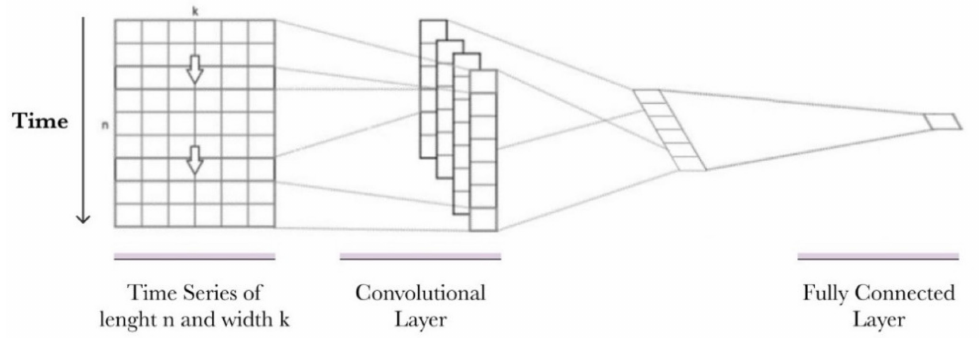
Figure 4. Convolutional neural network (CNN)